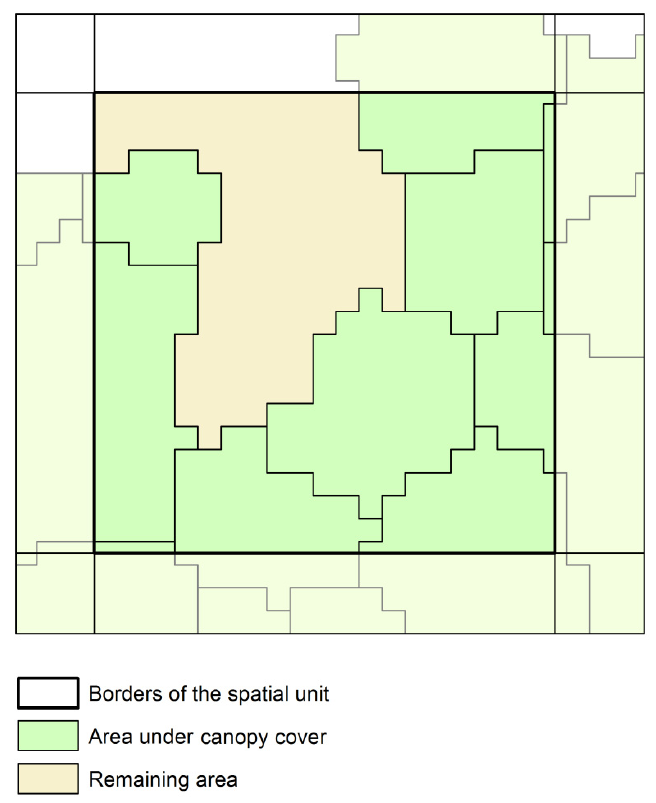
Figure 4. Area for which the percentage cover is calculated: Method 2